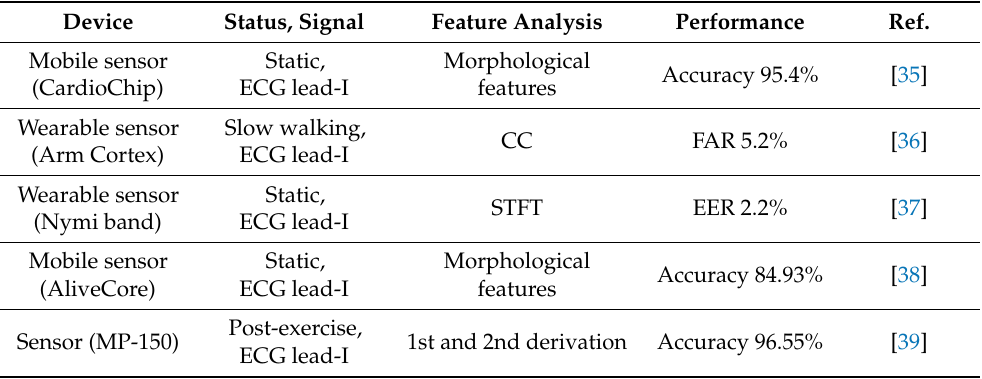
Table 1. User identification system analysis and performance using ECG in real